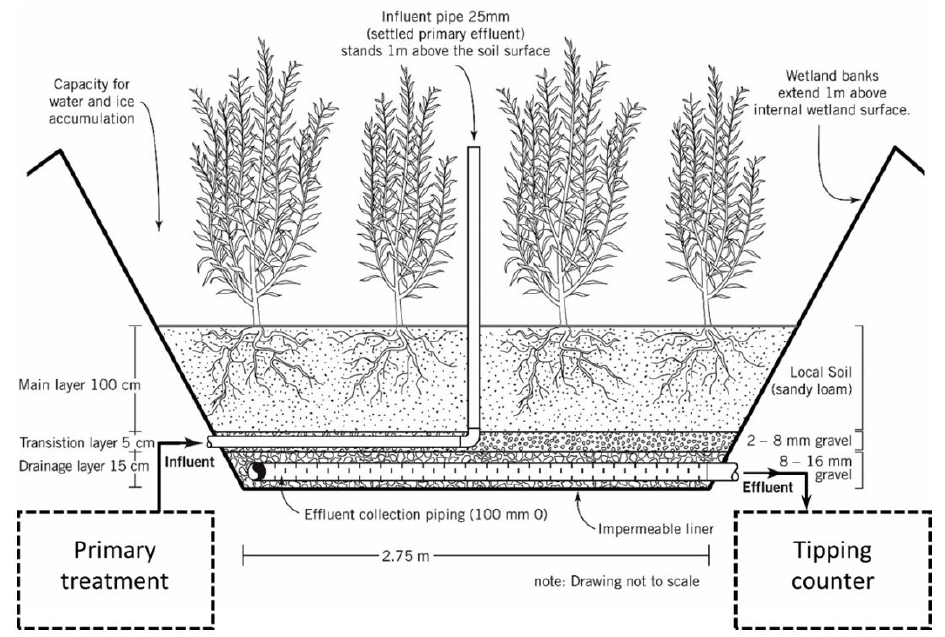
Figure 3. The schematic of the pilot plant and the cross sectional view of the tree planted beds.